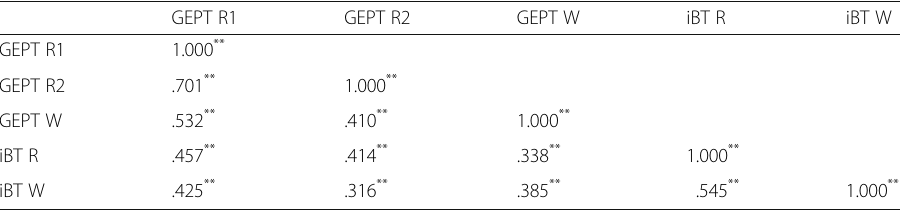
Table 7 Correlations among GEPT section scores and iBT section scores